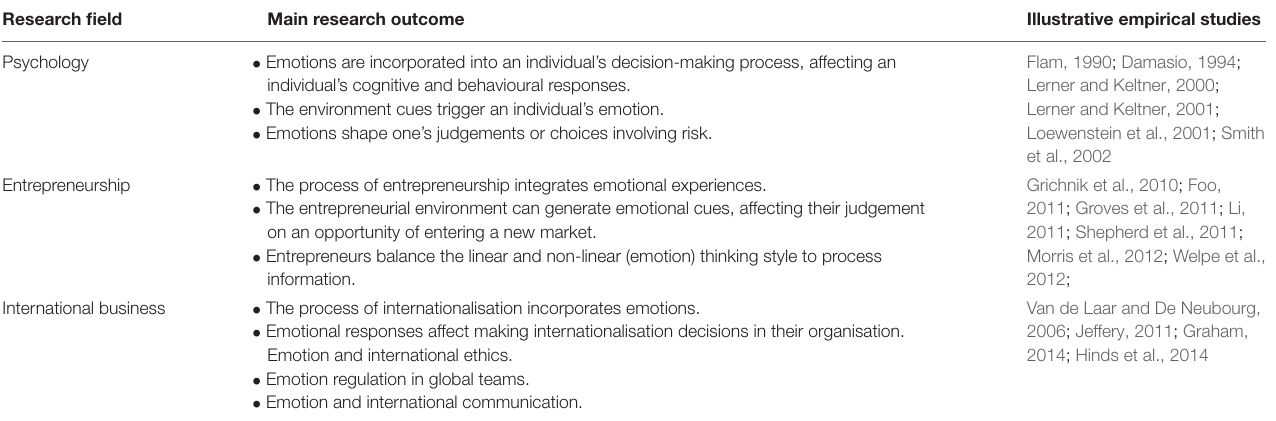
TABLE 3 | Literature review of emotion in the context of